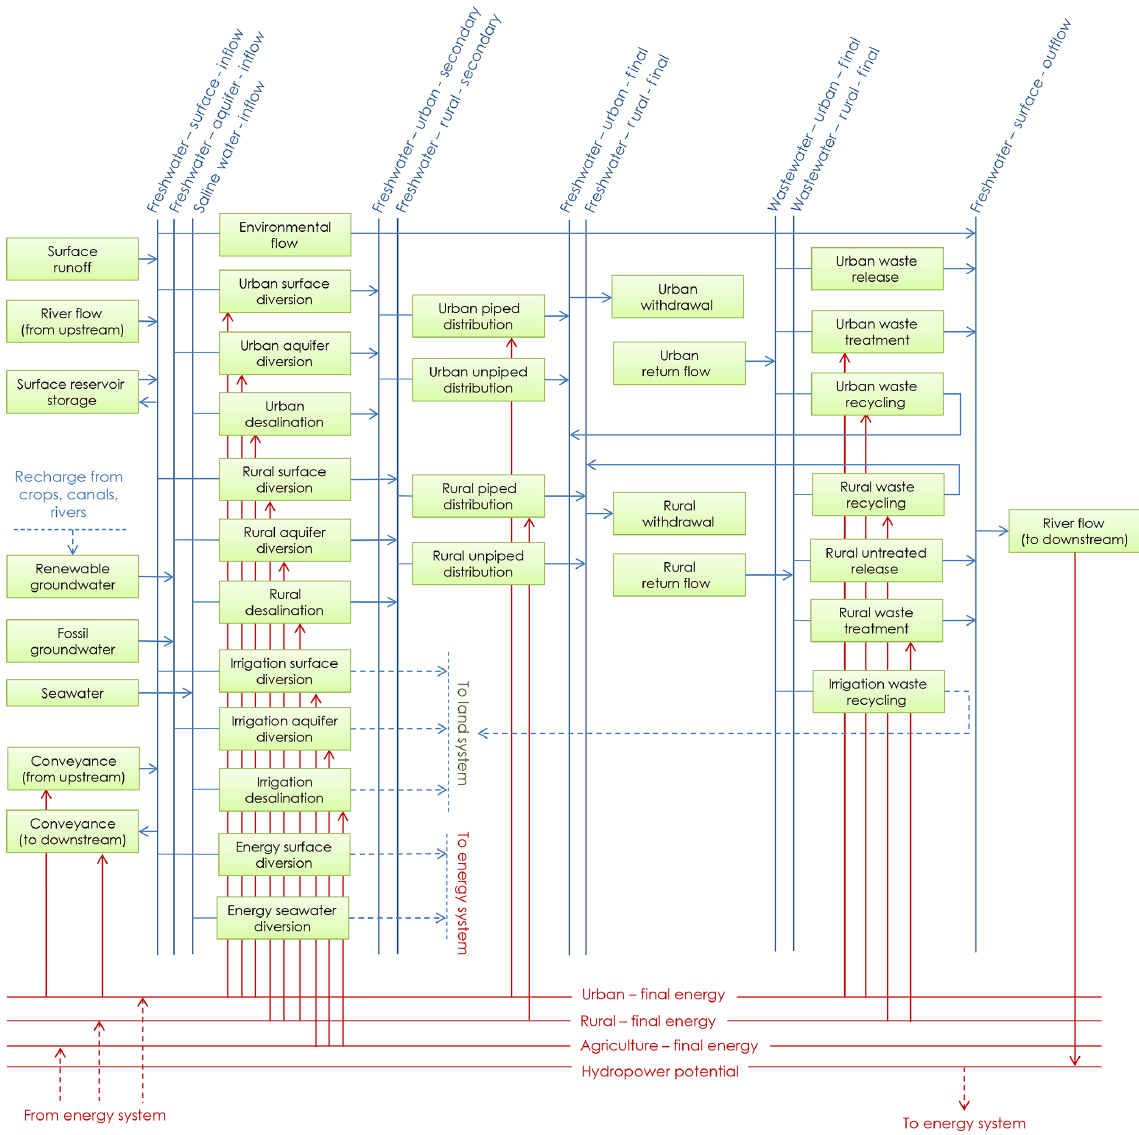
Figure 3. The water sector representation in each BCU using the MESSAGEix reference system scheme. The water sector is hard linked to the energy and land sector representations using the indicated